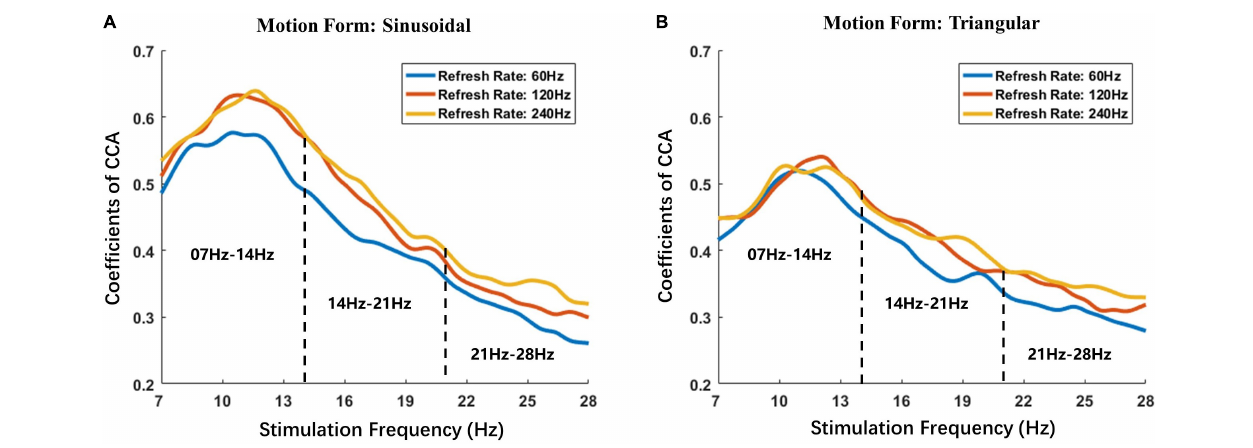
FIGURE 4 | Fundamental average frequency responses of all participants. (A) The frequency response of sinusoidal motion stimulation. (B) The frequency response of triangular motion stimulation. The horizontal axis indicates the stimulation frequency at the corresponding time, and the vertical axis indicates the CCA coefficient under the corresponding stimulation frequency. The blue solid lines depict the average visual response of all participants to stimulation with a refresh rate of 60 Hz, the red solid line depicts the average visual response to stimulation with a refresh rate of 120 Hz and the yellow solid line depicts the average visual response to stimulation with a refresh rate of 240 Hz. The black dotted line depicts the frequency